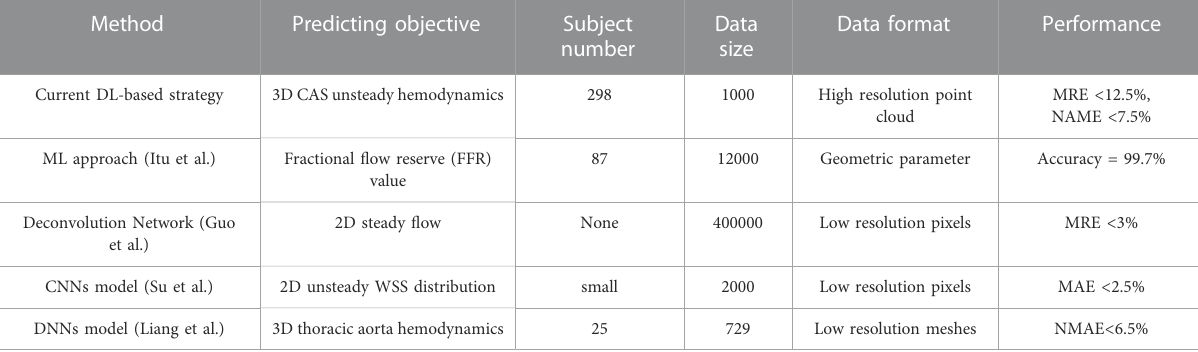
TABLE 4 Comparison of ML- and DL-based methods on hemodynamic